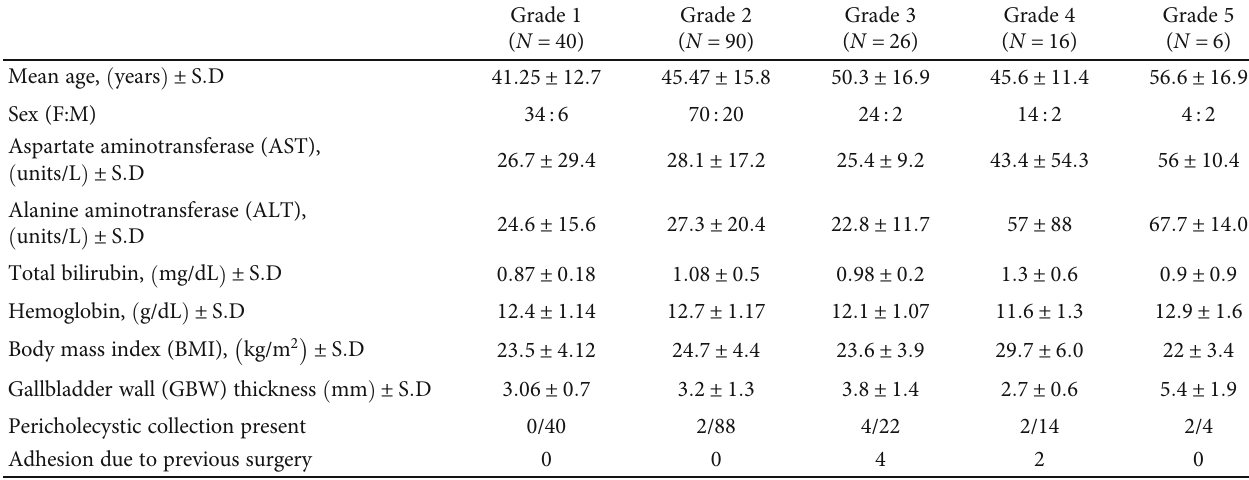
Table 2: Patient perioperative characteristics.